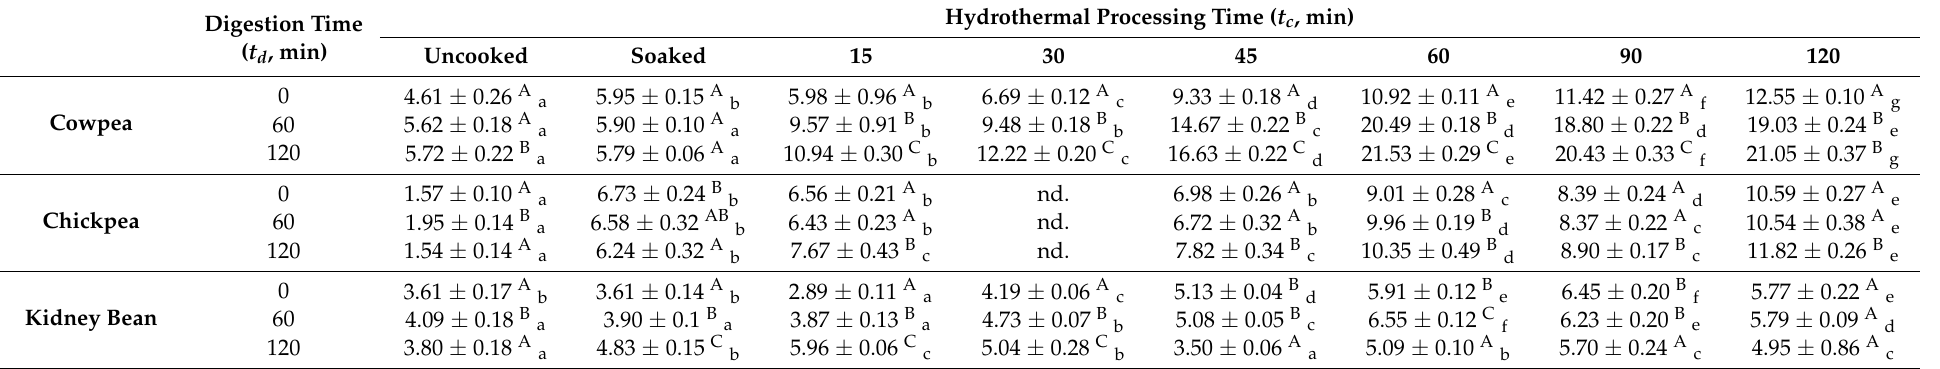
Table 2. The amount of digested starch (%) in uncooked, soaked and boiled legumes during in vitro gastric